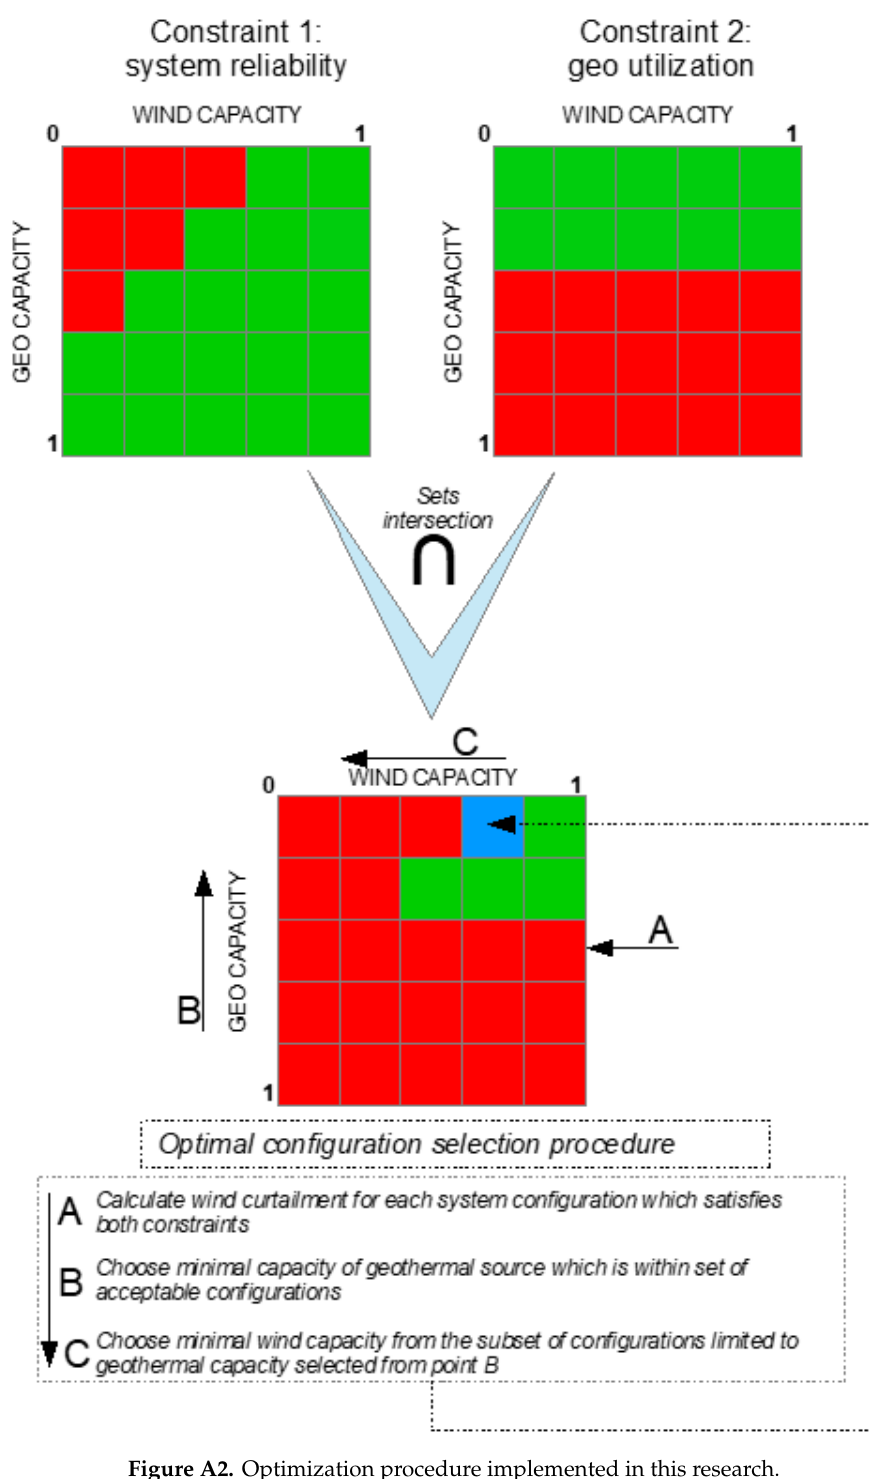
Figure A2. Optimization procedure implemented in this Figure B1. Optimization procedure implemented in this research.